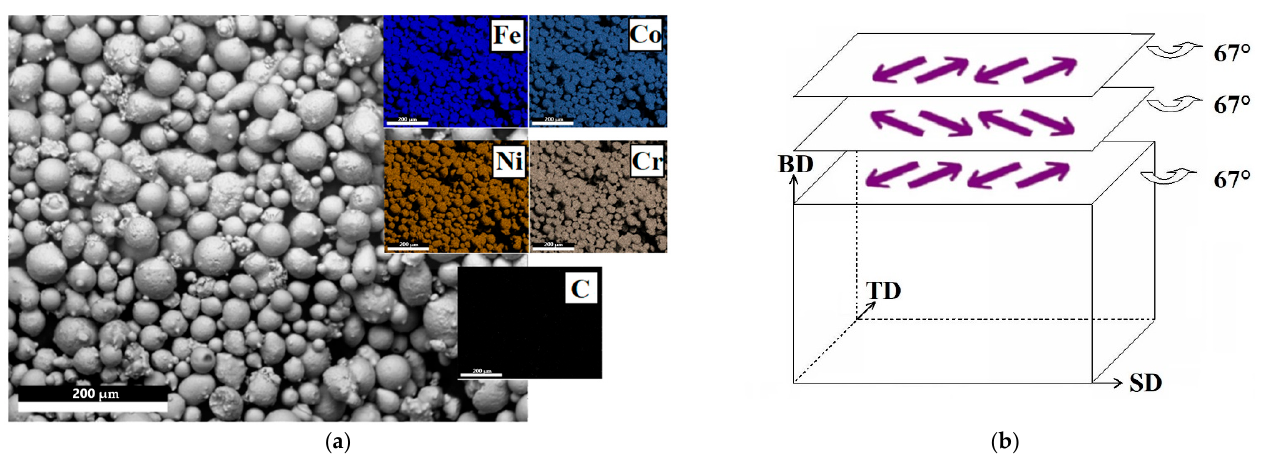
Figure 1. Morphology and EDS maps of Fe 65 (CoNi) 25 Cr 9.5 C 0.5 powder ( a ) and schematic illustration of the scanning strategy ( b ). BD, SD, and TD indicate building direction, scanning direction, and transverse direction, respectively; it should be noted that each laser beam track was declined 67° from the macroscopic scanning direction. Table 1. Chemical composition of the as-produced